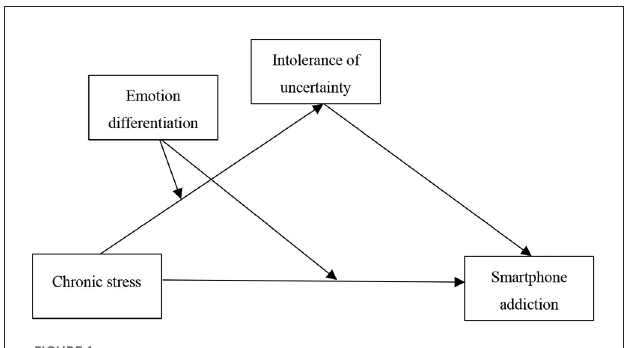
FIGURE1 Hypothesized